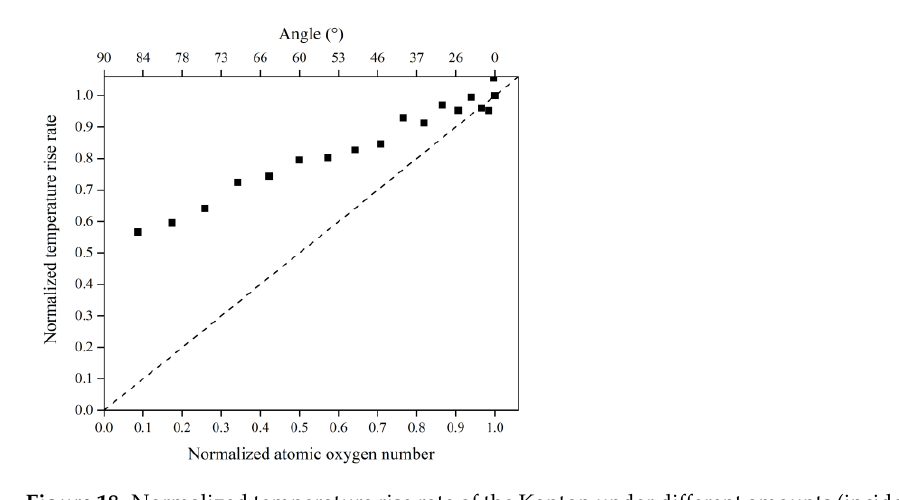
Figure 18. Normalized temperature rise rate of the Kapton under different amounts (incidence angles) of atomic oxygen impact.